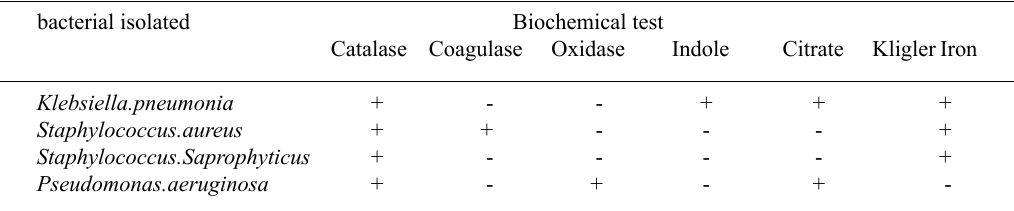
Fig. 1. Staph.aurues isolated (golden stain) on Mannitol salt table 3. Biochemical tests of bacterial isolated.